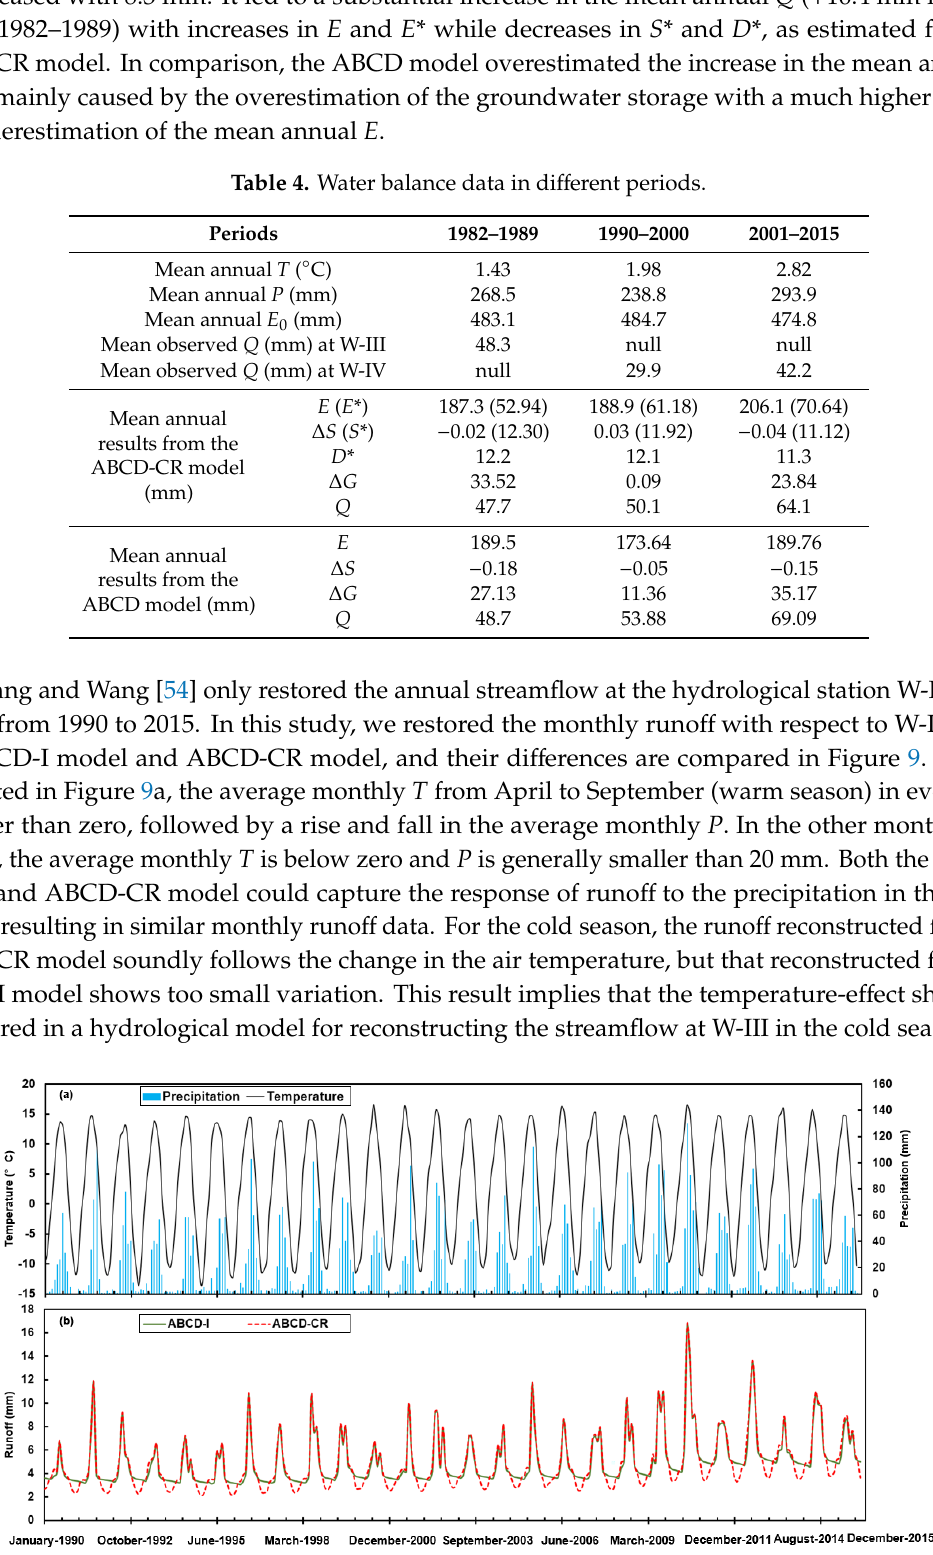
Table 4. Water balance data in di ff erent periods.